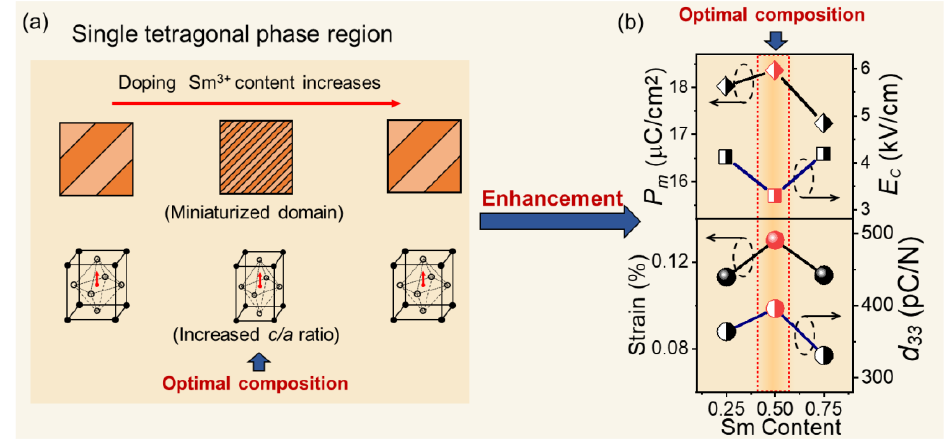
Figure 6. Schematic diagram of the enhanced piezoelectric effect in a single-tetragonal-phase region due to ( a ) the increased c/a ratio and miniaturized domain, compared with those of the adjacent compositions, showing ( b ) an increased P m , strain, and d 33 and a reduced E C .